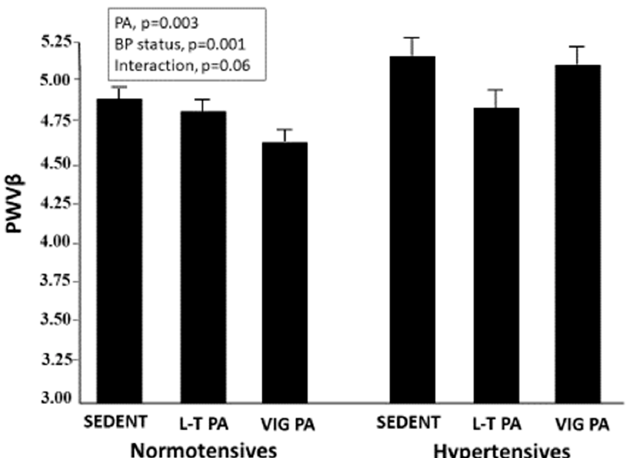
Figure 2. One-point pulse wave velocity in the study participants stratified according to physical activity level and blood pressure status. Legends as in Figure 1.